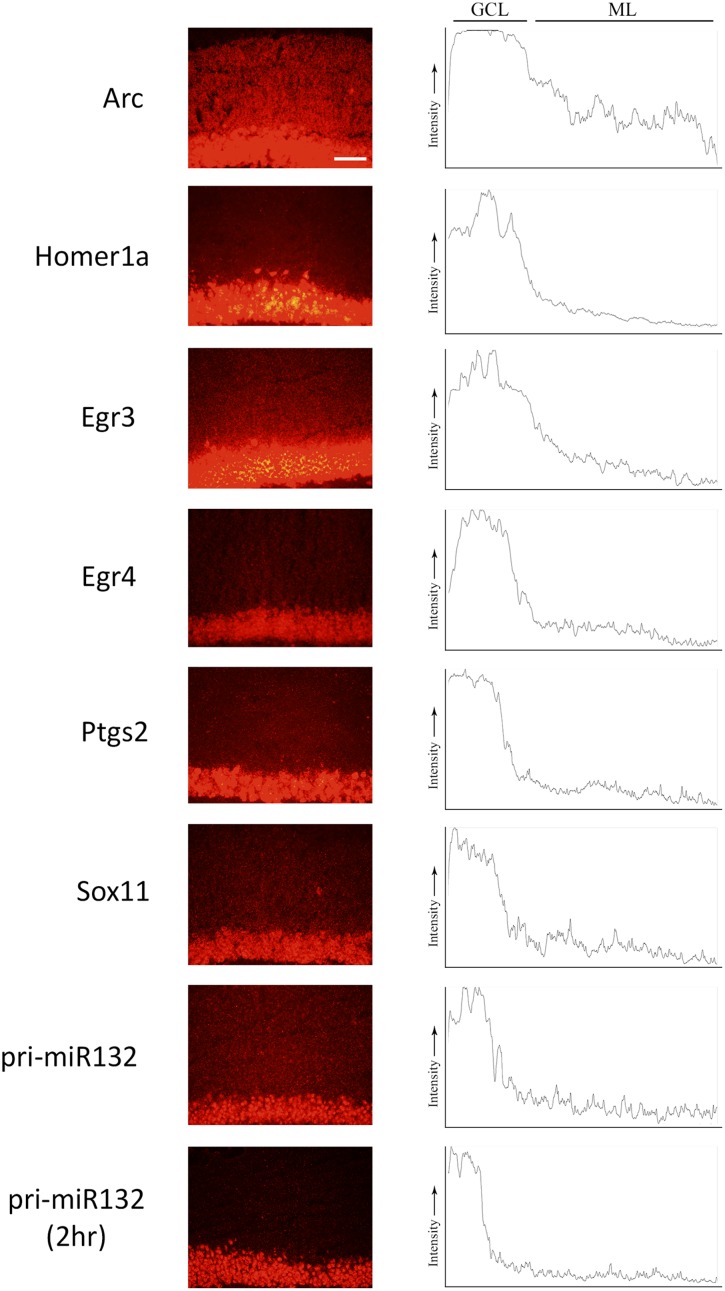
ImageJ was used to plot the intensity of the RNA assessed by FISH from the GCL and ML to visualize the signal across the two regions. Images were taken at the 4 h (and pri-miR132 2 h) timepoint at an optimal exposure for each gene. Plots are representative of the image displayed in this figure. Scale bar = 100 um.